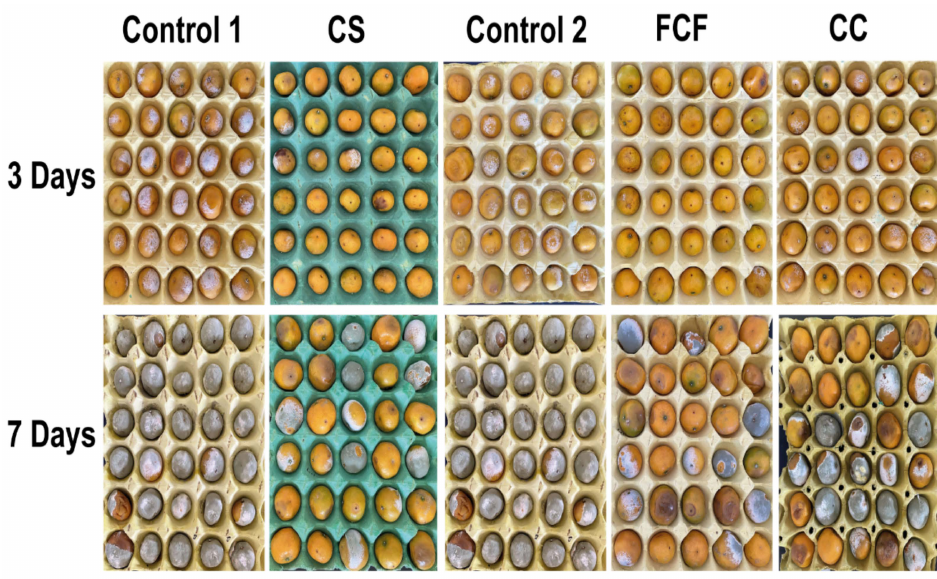
Figure 3. Biocontrol efficacy after 3 and 7 d have a significant inhibition of pathogens on citrus fruit. The treatments show a marked difference compared with the control, where the control effect is better at 3 d. CS, cell suspension; FCF, fermented cell filtrate; CC, culture filtrate; Control 1, water; Control 2, NB media.